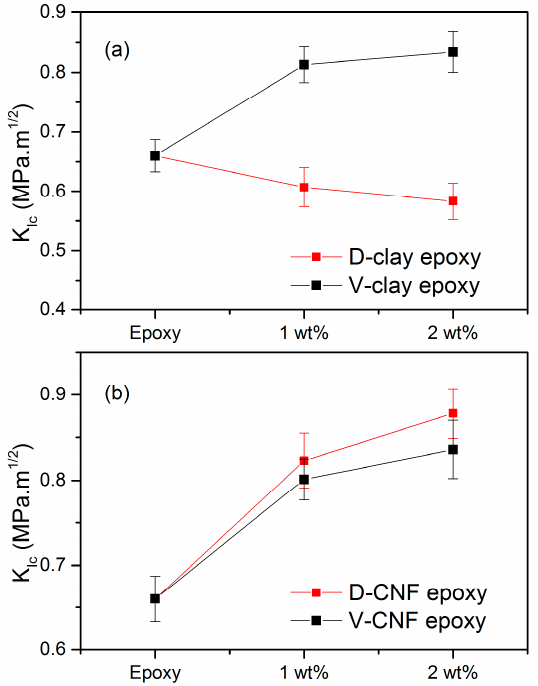
Figure 10. Critical stress intensity factor of nanocomposites with different filler loading ( a ) MMT clay ( b ) CNF.